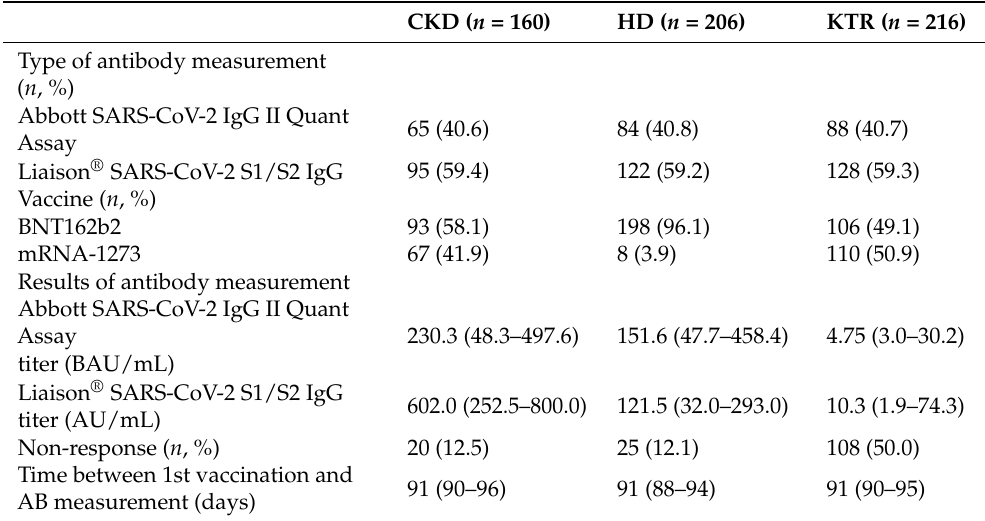
Table 2. Type of vaccine and antibody measurement in CKD and HD patients, and KTR. Continuous data is displayed as median, 25%, and 75% percentiles. Numeric data is displayed as number of participants ( n ) and percentage (%) where appropriate (sums do not add up to 100% due to rounding). CKD ( n = 160) HD ( n = 206) KTR ( n = 216)